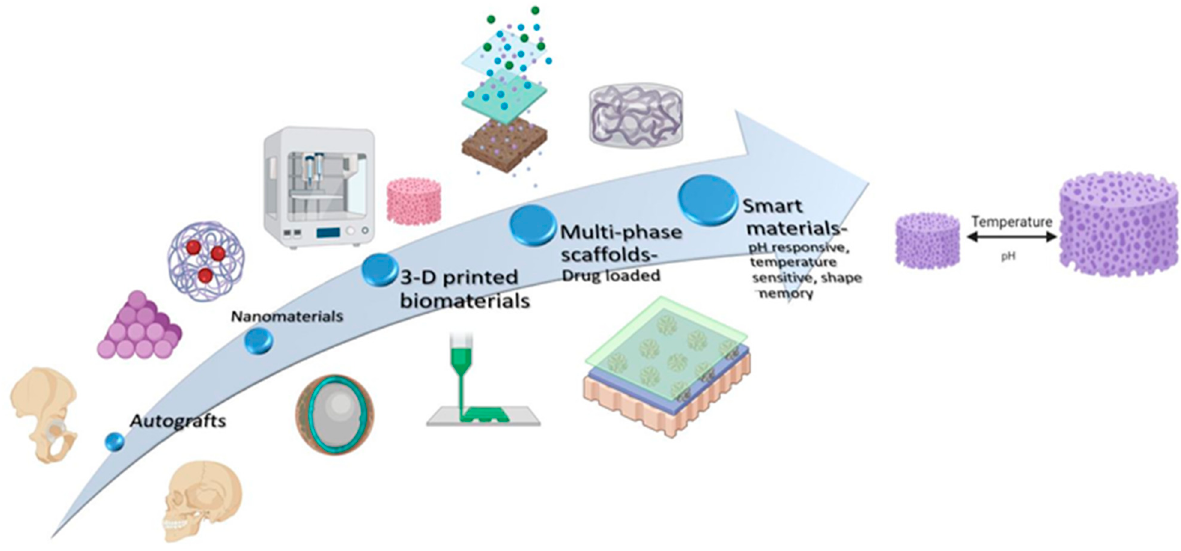
Figure 2. Evolution of biomaterial design and construction used for periodontal regeneration .